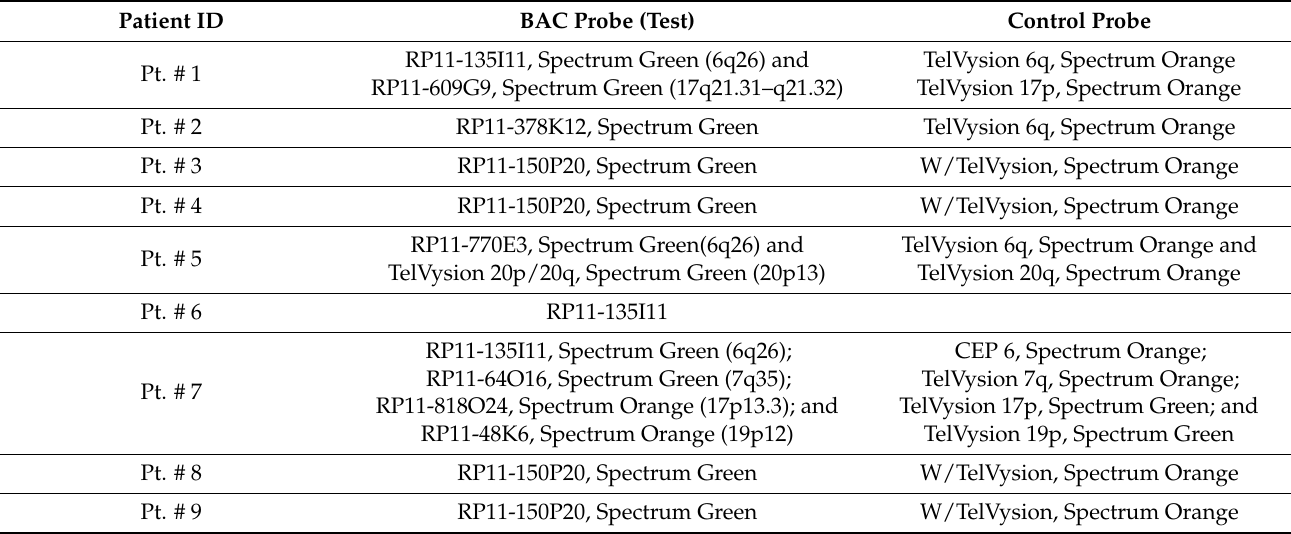
Table 1. Summary of BAC and control probes for validation of aCGH